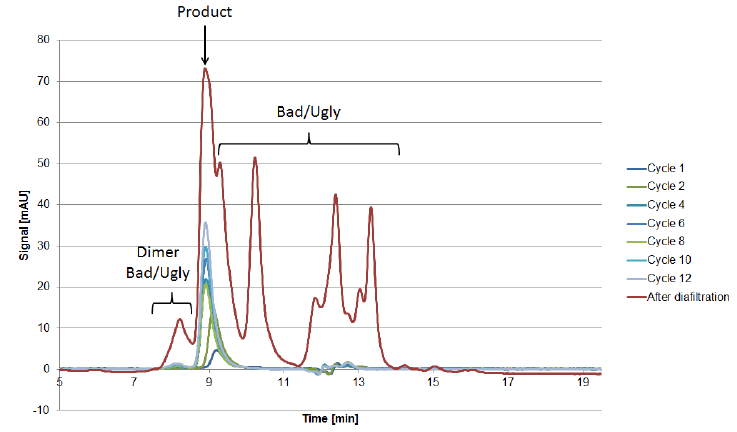
Figure 10. SEC chromatograms after various cycles as well as the broth after diafiltration. Table 6. Classification of CHO proteins identified via LC-MS/MS analysis and characterized by 2D-PAGE gel. Comparison of theoretical (UniProt; pI calculated according to the amino acid sequences) and observed MW and pI with respect to the spot position on the 2D-PAGE